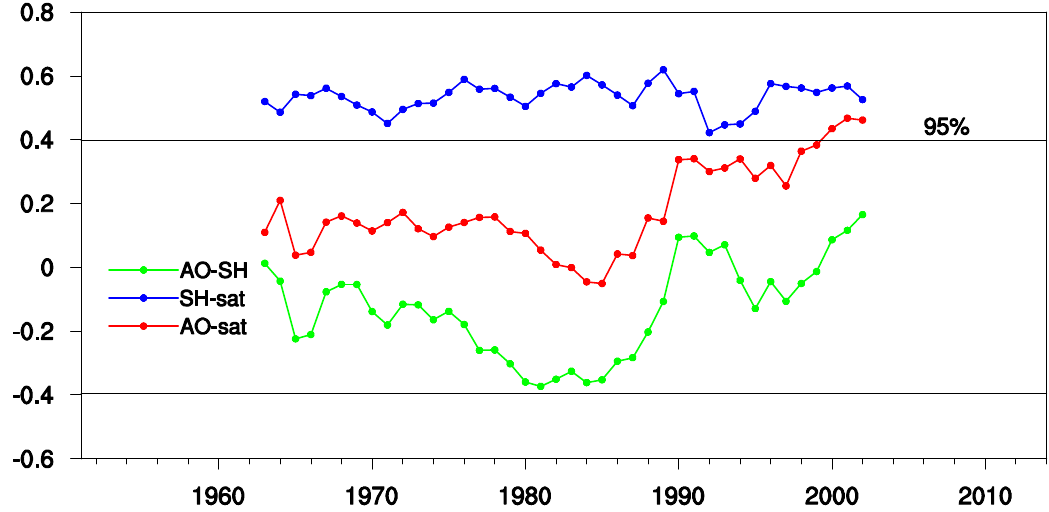
Figure 3. 25-year moving correlation coefficients of the winter AO (red line) and SH (blue line) indices with the PC time series corresponding to EOF1 of the southeast Asian winter SAT. The 25-year moving correlation between the winter AO index and winter SH index is also presented in Figure 3 (green line). The horizontal black line indicates correlation coefficient significant at the 5% level. Years displayed in the X-coordinate correspond to the central years of the 25-year moving window.